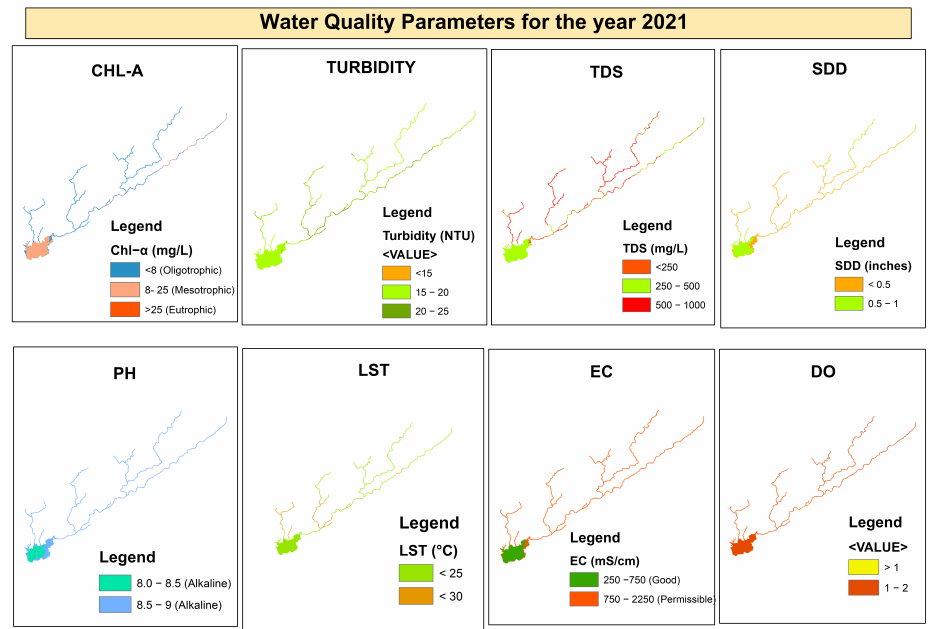
Figure 5. Water quality features, i.e., Chl − α , turbidity, TDS, SDD, pH, LST, EC, and DO, extracted from Landsat 8 images using the adapted equations mentioned in Table 2 for the year